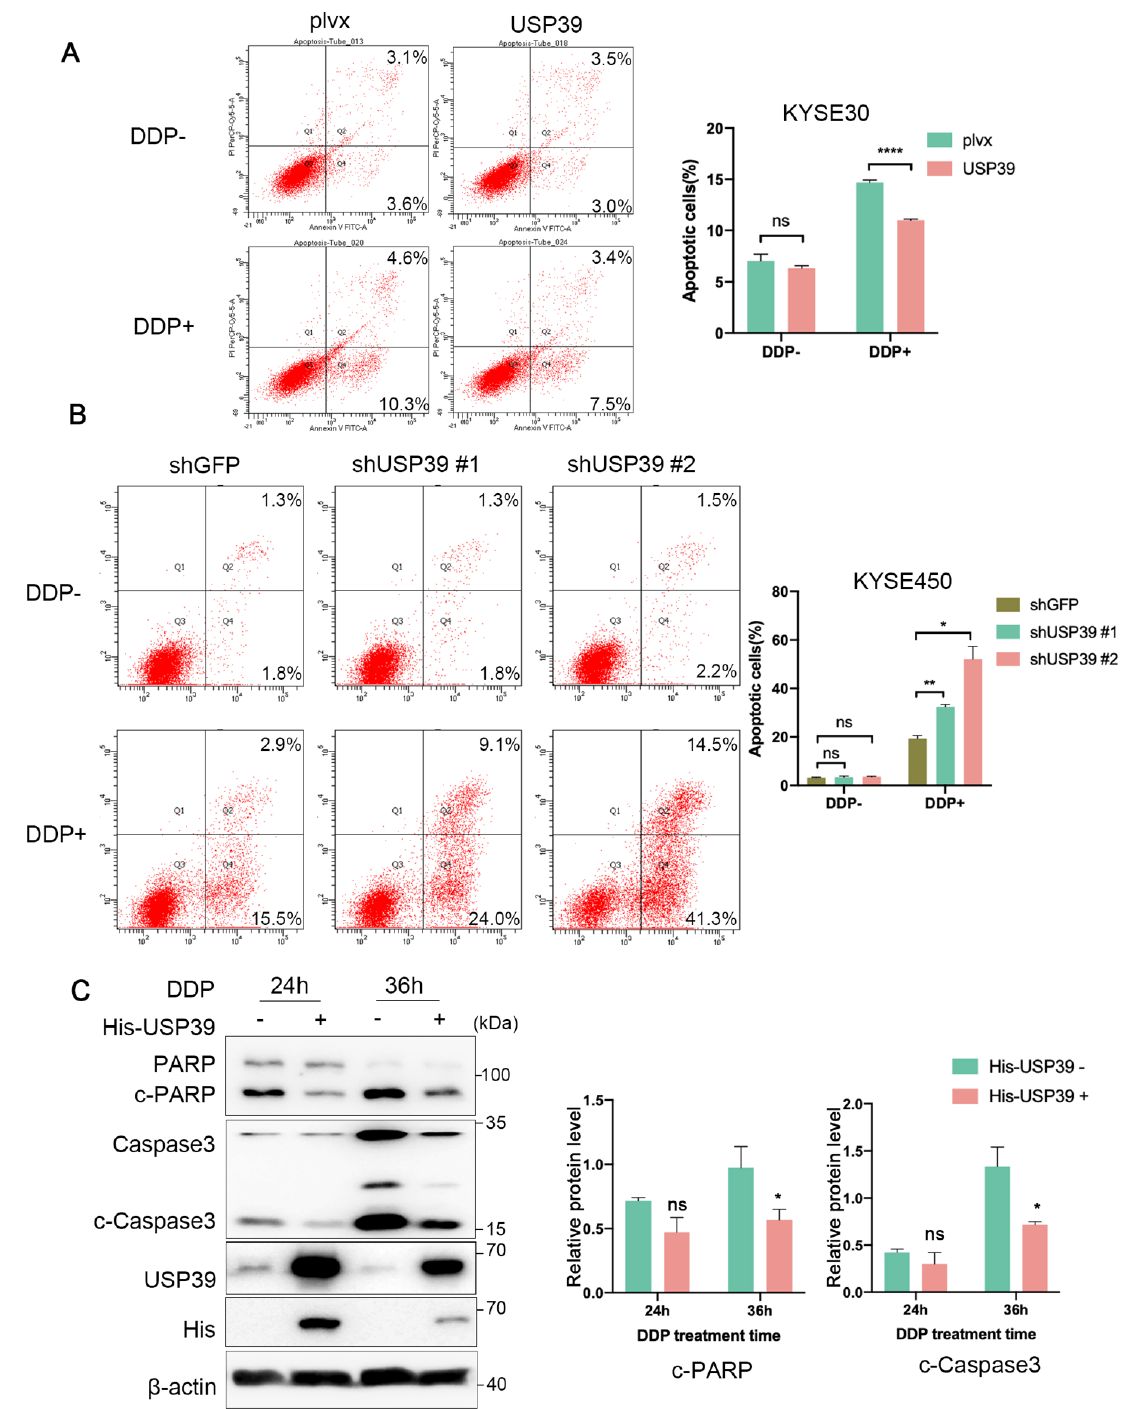
Figure 3. USP39 promotes chemoresistance in ESCC cells. ( A ) Cell apoptosis detected by the Annexin V-PI assay in USP39-overexpressed KYSE30 and control cells with or without DDP (14 µg/mL) treatment. n = 3. ( B ) Cell apoptosis detected by the Annexin V-PI assay after USP39 knockdown in KYSE450 cells with or without DDP (7 µg/mL) treatment. n = 3. ( C ) Representative immunoblotting analysis of the cleaved PARP and Caspase3 expression in USP39-overexpressed KYSE30 cells with DDP treatment. The blot was analyzed by Image J. Relative protein levels were normalized to β -actin. Data in A, B, and C represent mean ± S.D and were analyzed by unpaired two-tailed Student’s t -test. ns = no significant, * p < 0.05, ** p < 0.01, **** p <